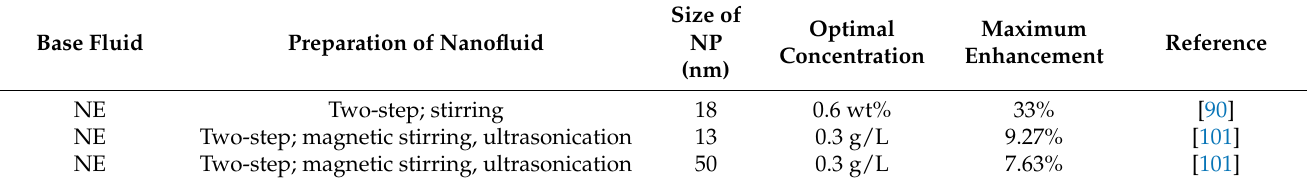
Table 3. Al 2 O 3 DC-BDV overview table. The size of NP refers to the nanoparticle core size, while the optimal concentration indicates the concentration value for which the maximal enhancement of DC-BDV was found. Base